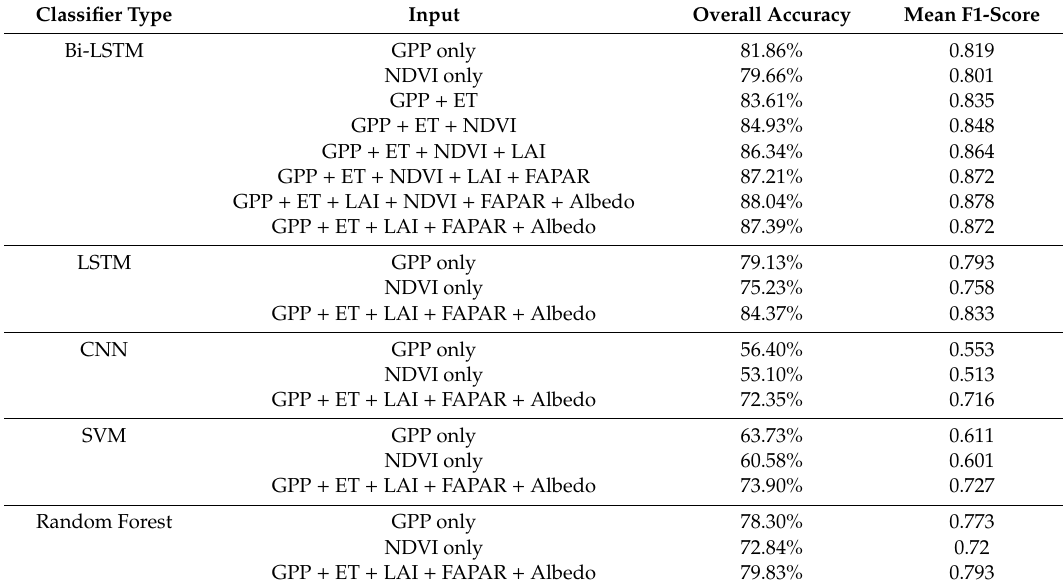
Table 3. Comparison of the classification accuracies between di ff erent models and di ff erent quantitative remote sensing